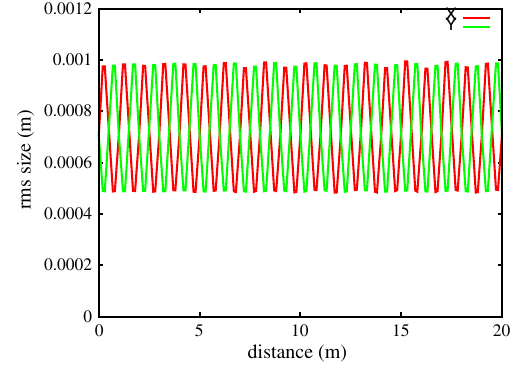
FIG. 3. RMS envelope evolution of the beam. be a Gaussian function given in Fig. 1. We computed the electric field along the x axis using the above direct gridless spectral solver with 15 × 15 modes and the electric field from a second order finite difference solver with 129 × 129 grid points. The results are shown in Fig. 2. The solution of the spectral solver agrees with that of the finite difference solver very well with even 15 × 15 modes due to the fast convergence property of the spectral method. The relative maximum field difference